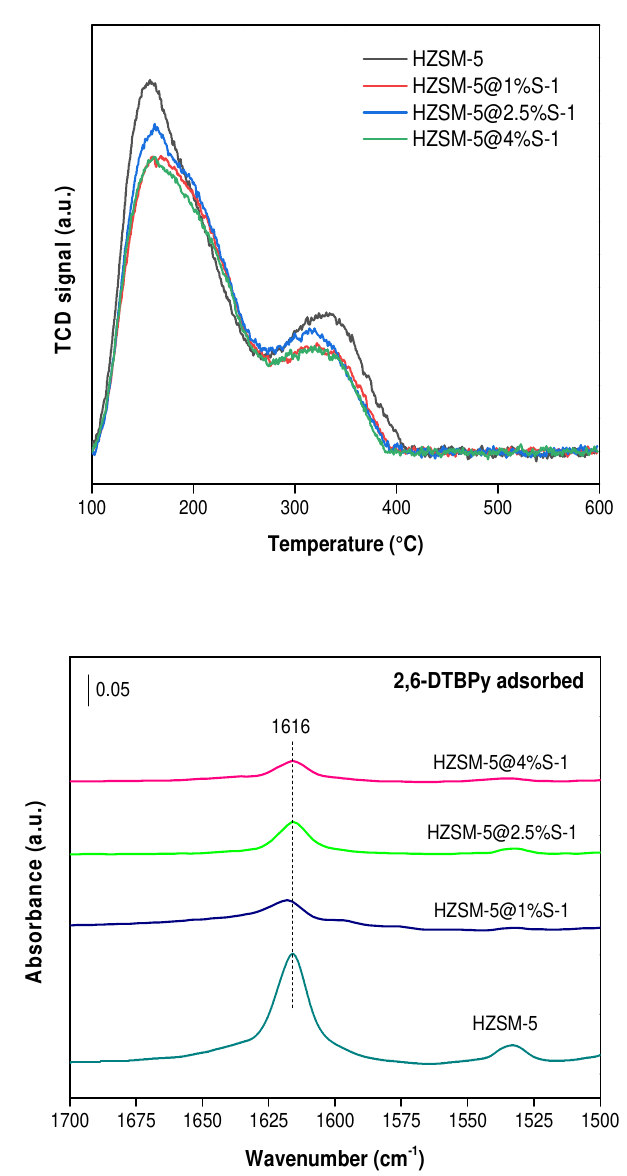
Figure 5. ( a ) NH 3 -TPD curves of the parent HZSM-5 and HZSM-5@silicalite-1 samples; ( b ) 2,6-DTBPy adsorbed FT-IR spectra of the parent and modified HZSM-5@silicalite-1 samples.